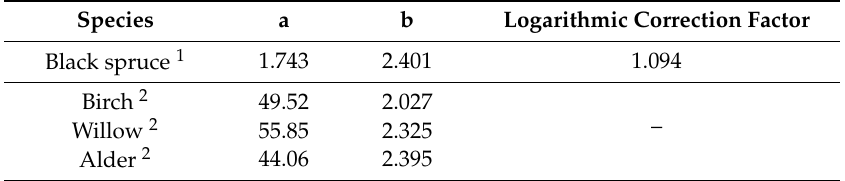
Table 1. Constants for the allometric Equations used in the